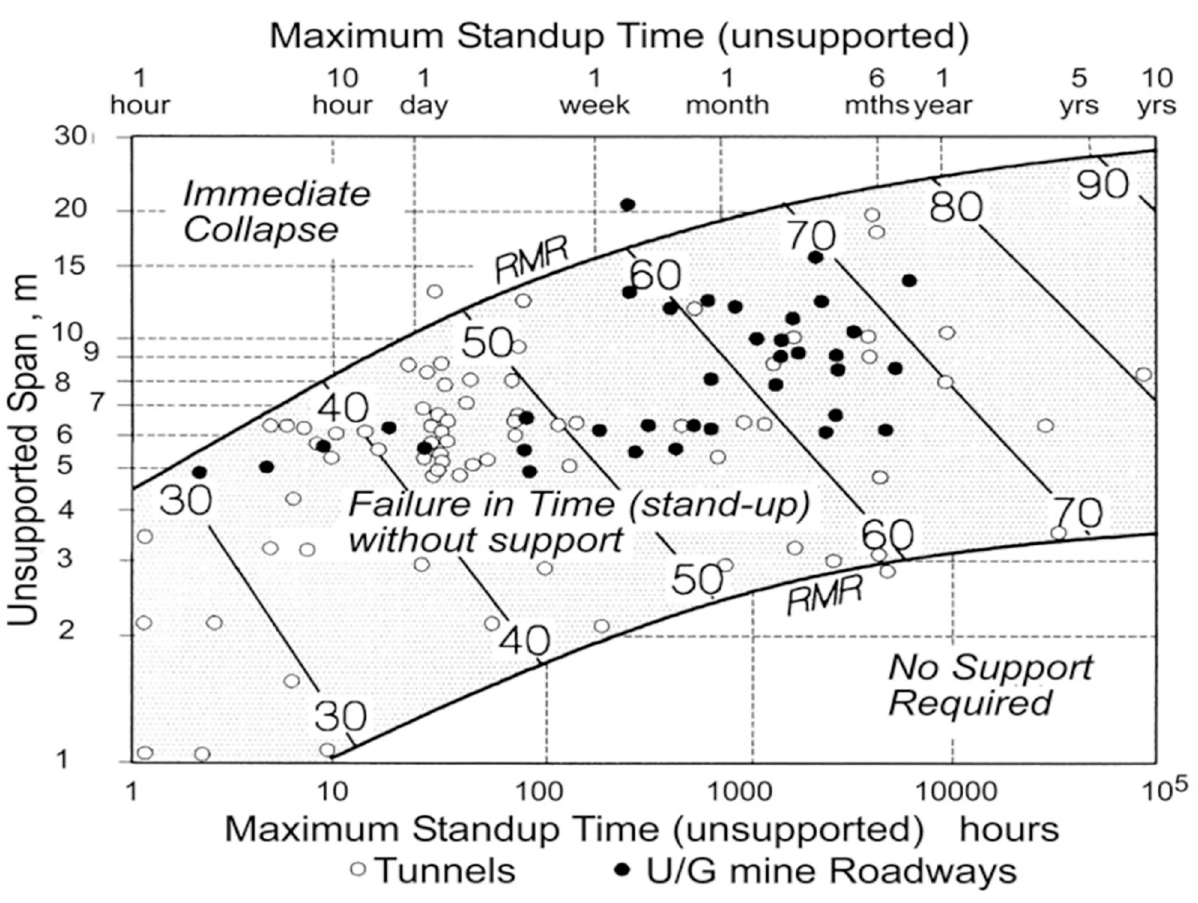
Fig 6. Self-stabilization time judgment based on RMR classification.